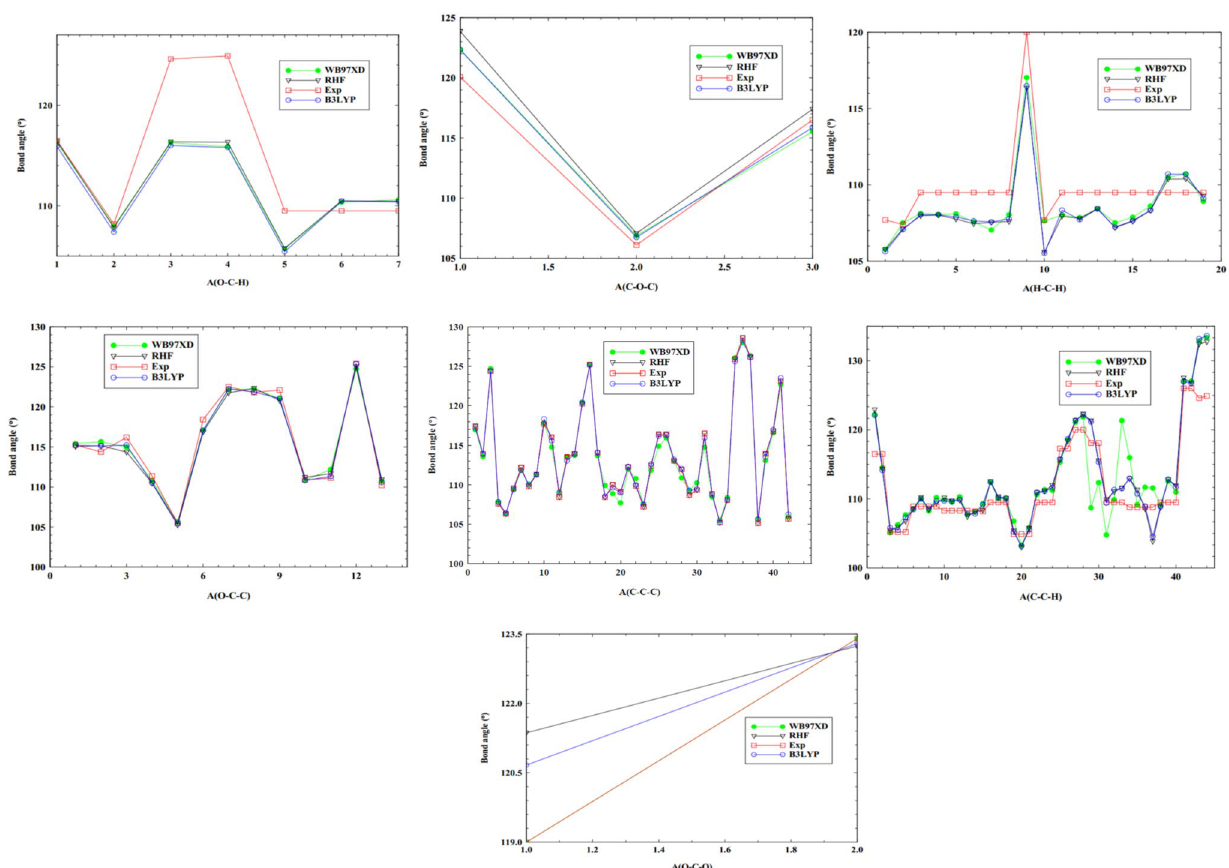
Fig. 4 Variation of the angles calculated by B3LYP, wB97XD and RHF. The experimental data [4] are also illustrated for